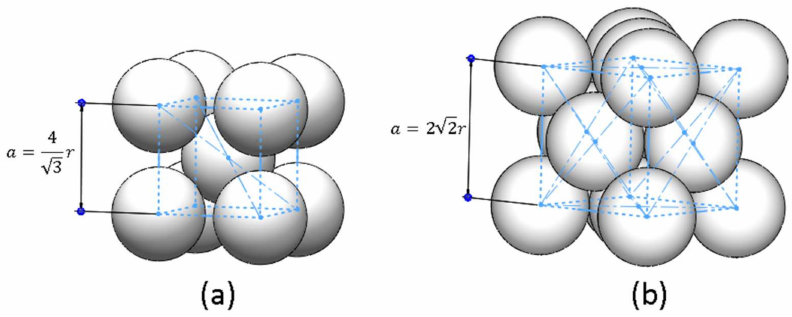
Figure 3. ( a ) Body-centered cubic unit cell; ( b ) Face-centered cubic unit